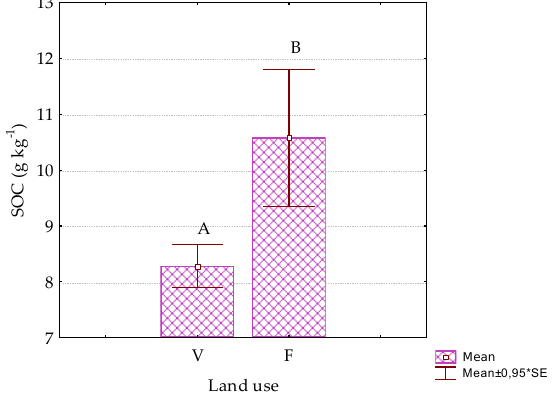
Figure 9. Effect of land use on soil organic carbon content. Significant differences between soil groups are labeled with different letters, p < 0.01 (N = 60).